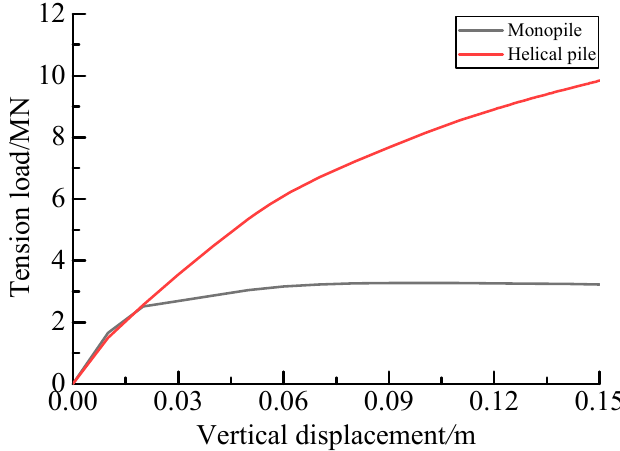
Figure 9. Uplift load-displacement curves.